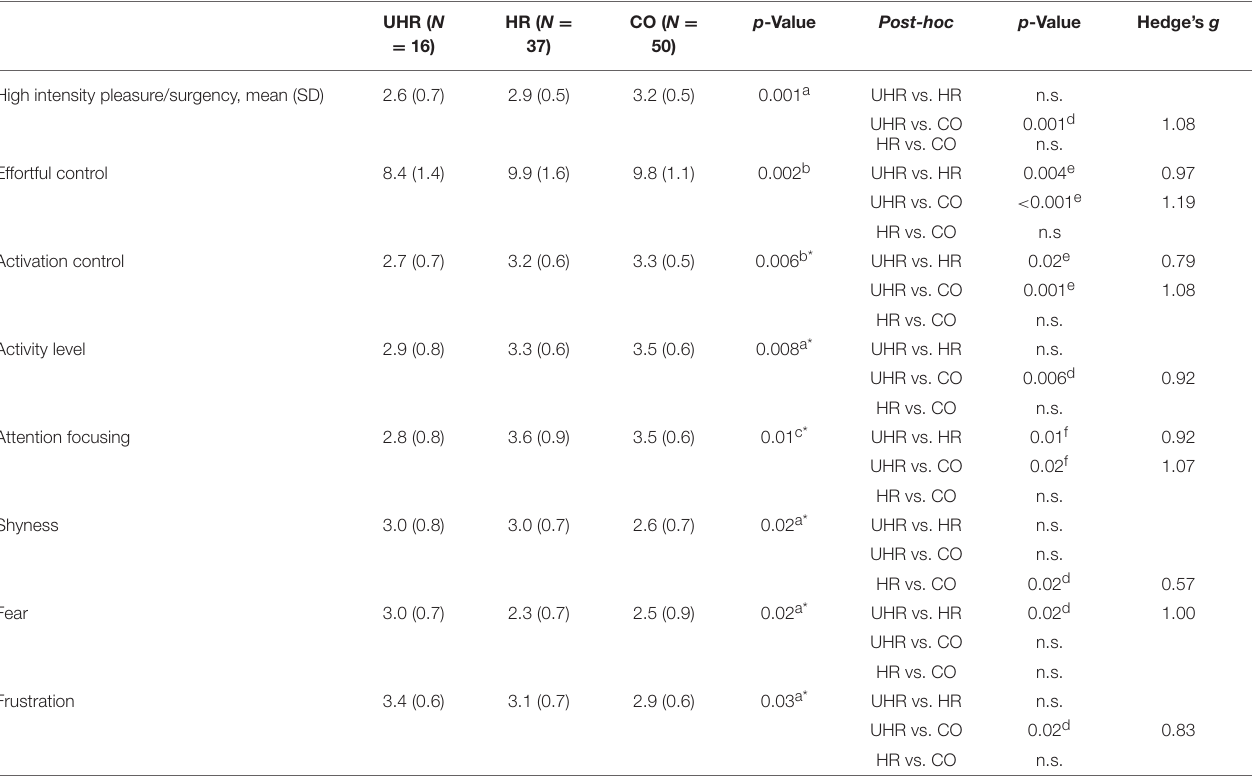
TABLE 6 | Temperament scores across the UHR and HR offspring subgroups and CO group with statistically significant between-group